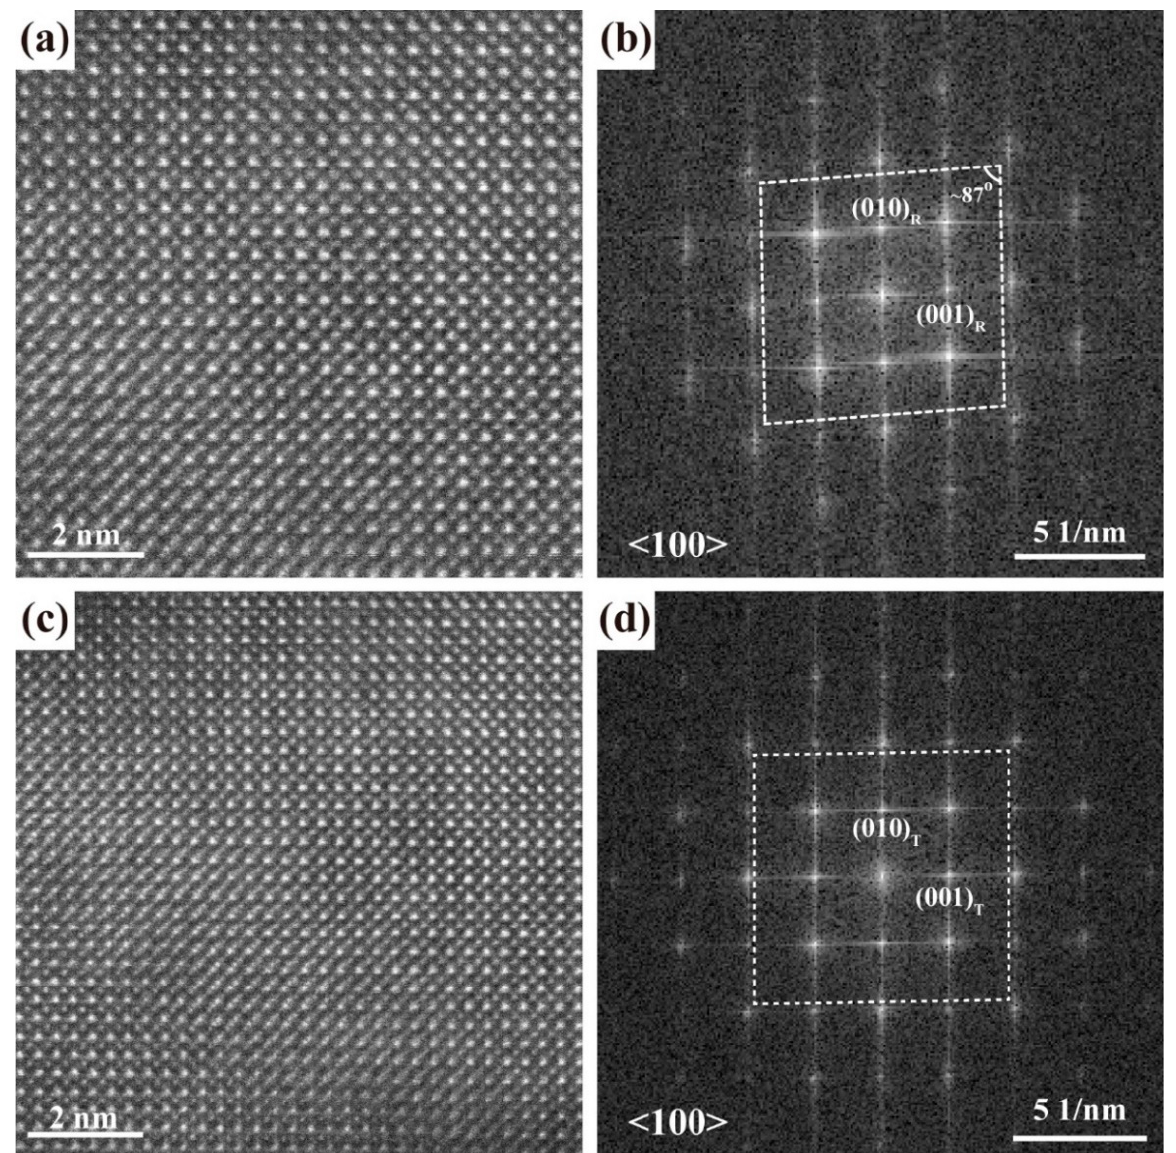
Figure 4. STEM analysis. Atomic scale HAADF-STEM images from ( a ) an R phase region and ( c ) a T phase region of the as-grown BZT film. Corresponding electron diffraction patterns via FFT are shown in ( b , d ) for the T and R phases, respectively.